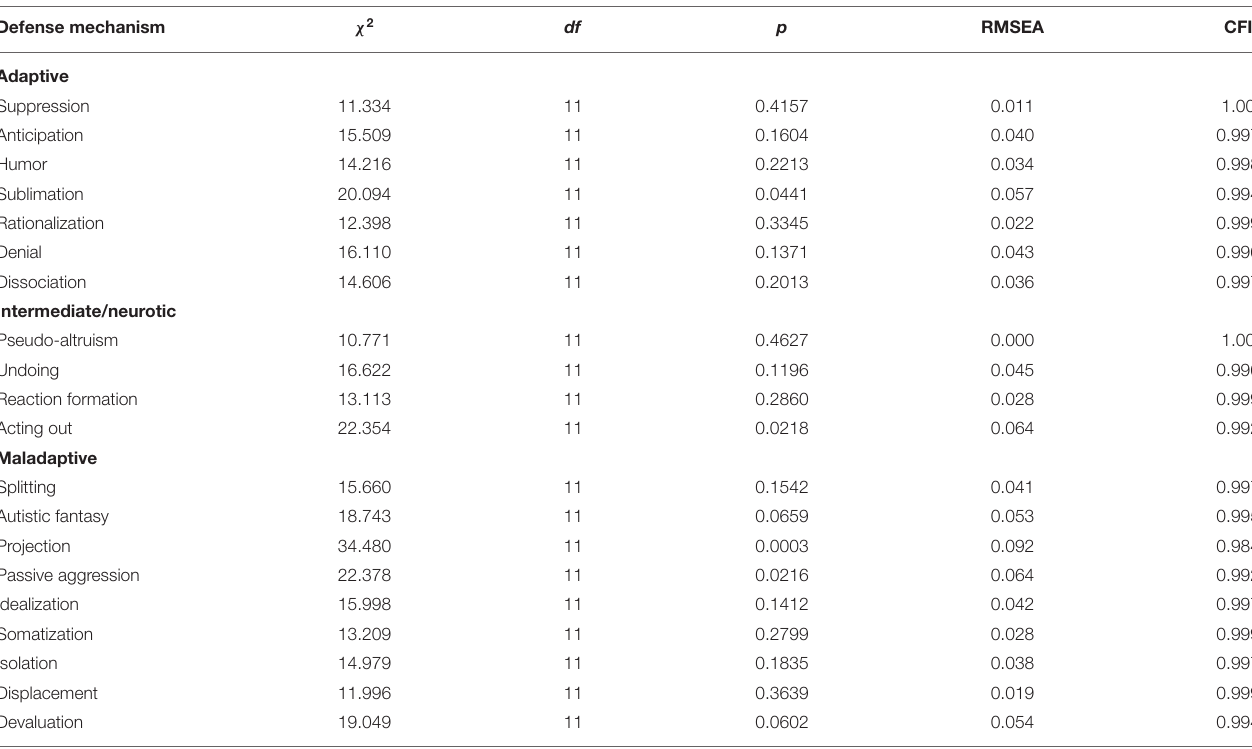
Table A1 | Model Fit Indices of all 20 structural equation